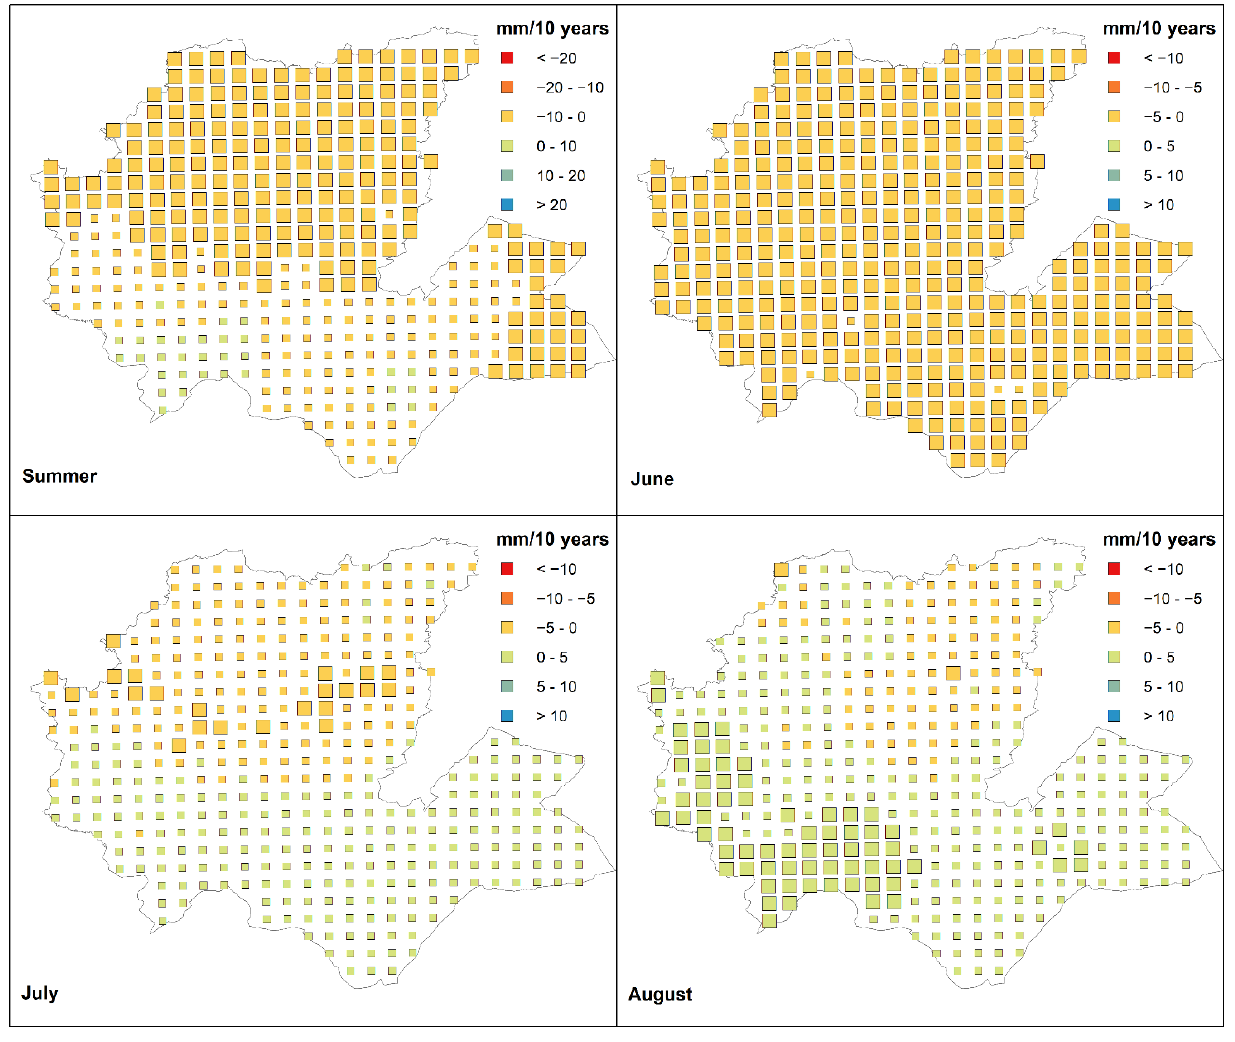
Figure 8. Theil – Sen estimator for summer season with months expressed in mm per decade. Squares’ dimensions indicate the significance level of the trend: large squares: p < 0.05, small squares otherwise.